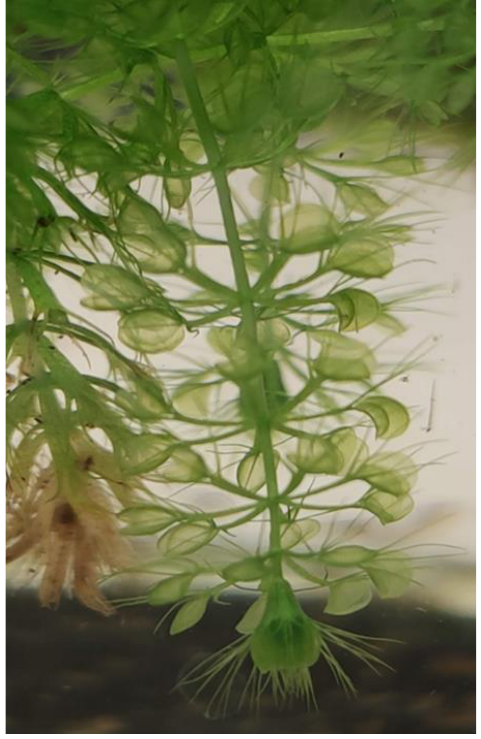
Figure 1. Aldrovanda vesiculosa L. shoot and leaves.